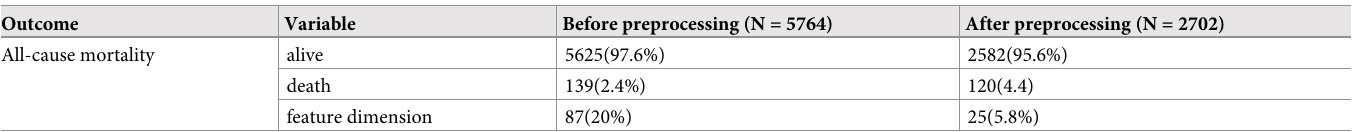
Table 2. Patient